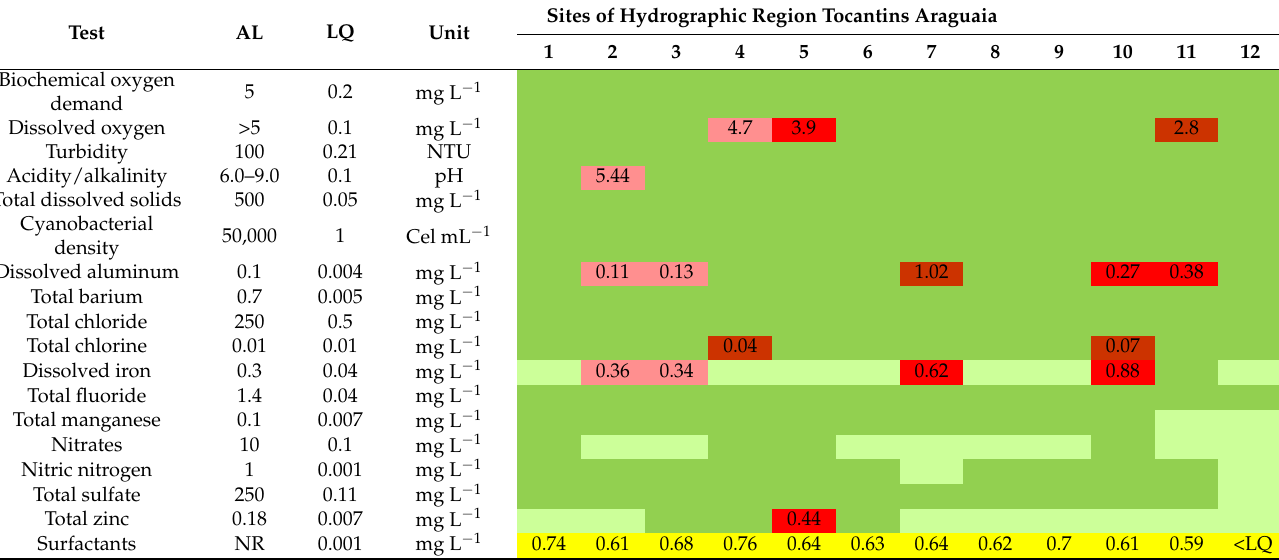
Table 1. Analysis of surface water samples collected at eleven sampling sites (1–11) and the reference (12) site in Tocantins.